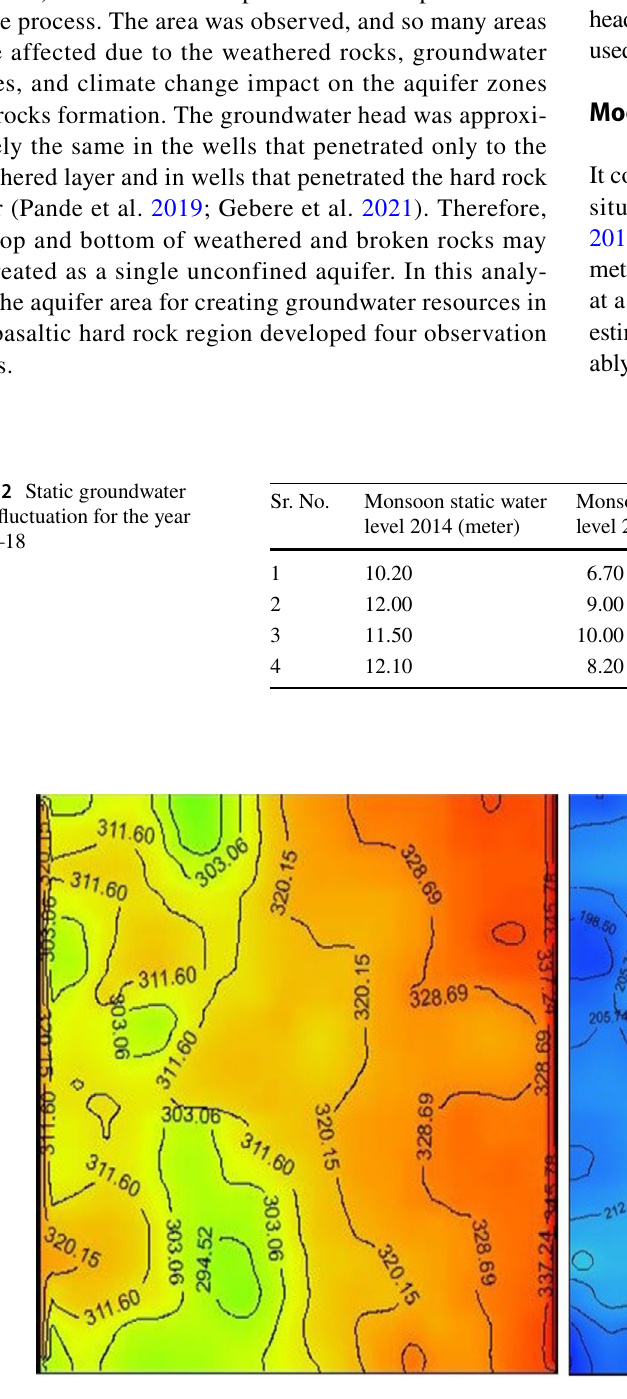
Fig. 7 Groundwater level head of layers 1 and